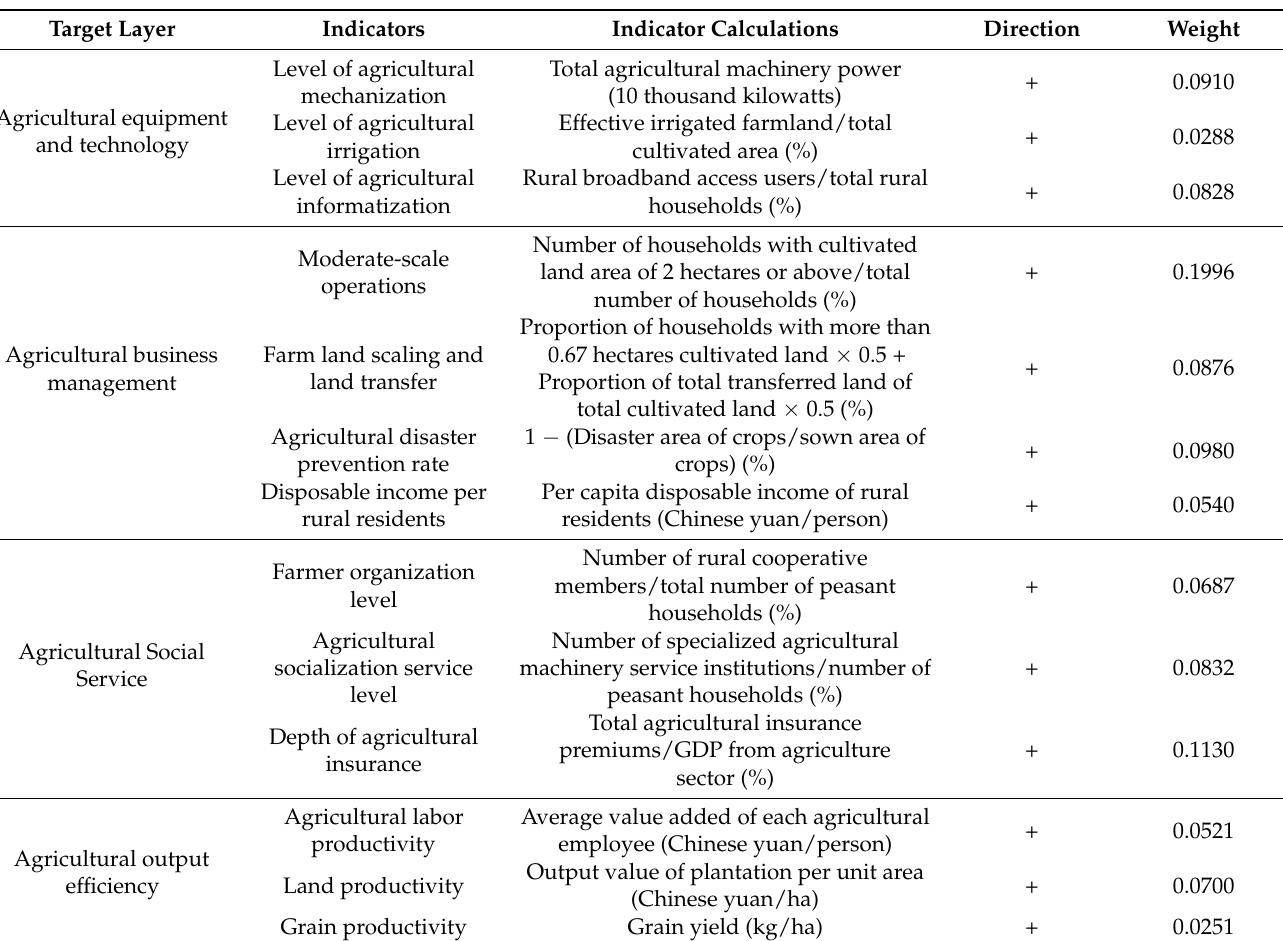
Table 1. Evaluation index system of agricultural modernization level.